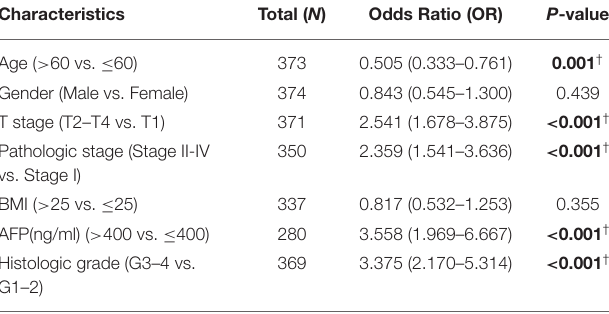
TABLE 1 | Logistic regression analysis was performed to estimate the relationships between cell division cycle-associated protein 2 (CDCA2) expression and clinicopathological characteristics.